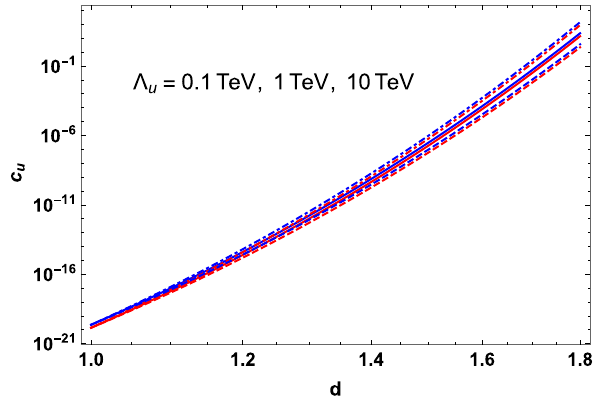
Fig. 6 Variation of vector coupling with the scaling dimension for unparticle exchange between the Earth and GP-B satellite from the geodetic (blue) and the frame-dragging (red) measurements. The solid, dot-dashed, and dashed lines correspond to the energy scale 1 TeV, 10 TeV, and 0 . 1 TeV